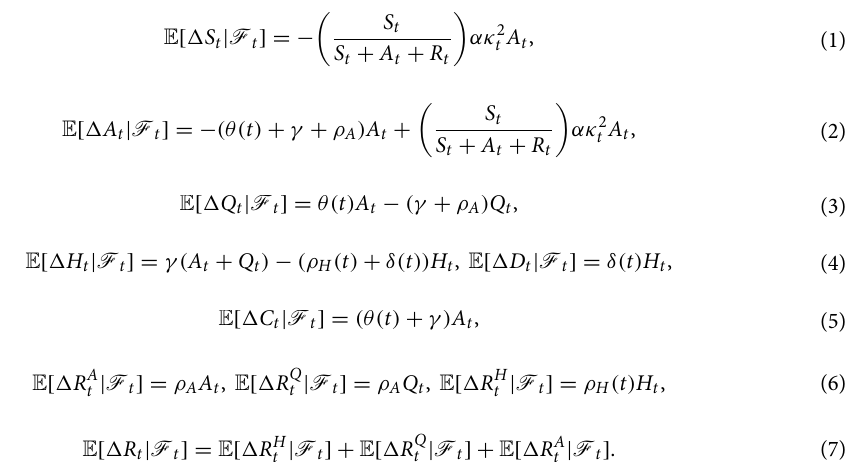
Figure 1. A graphical representation of the disease propagation model. S t , A t , H t , Q t , D t are the number of susceptible, infected, hospitalized, quarantined, and deceased people at time t respectively. R represent the recovered population from quarantined, hospitalization, and infected but asymptotic stages respectively. The rate parameters are as described in “Disease propagation model”